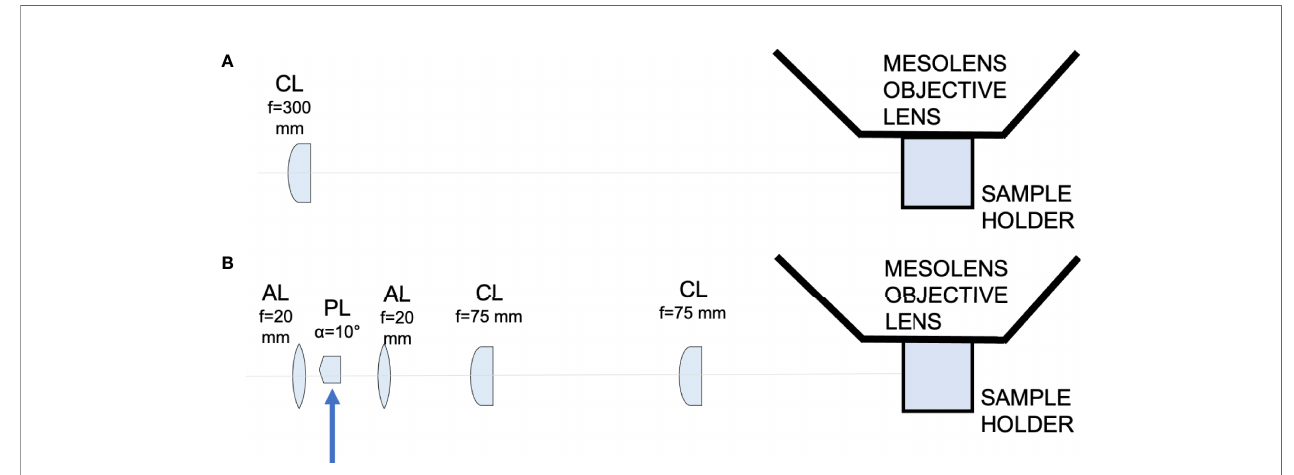
FIGURE 1 | Schematic diagram showing the light-sheet illuminators. (A) Schematic diagram showing the Gaussian light-sheet illuminator. The light-sheet is shaped using a cylindrical lens (CL, f = 300 mm) and directed to the sample plane. The sample is placed in a quartz cuvette to be imaged by the Mesolens. (B) Schematic diagram showing the Airy light-sheet illuminator. The light-sheet is shaped using a combination of aspherical lenses, aspheric lens (AL, f = 20 mm), a Powell lens (PL, fan angle = 10°), aspheric lens (AL, f = 20 mm), two identical cylindrical lenses (CL, f = 75 mm). The Powell lens was moved out of the optical axis to create the Airy light-sheet, as indicated by the blue arrow in the